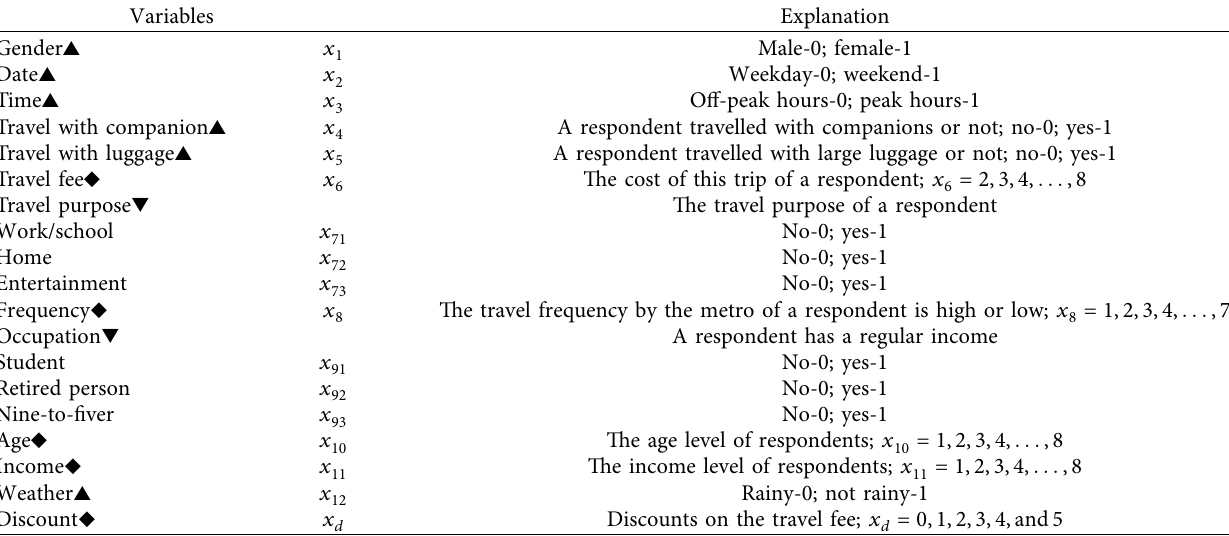
Table 5: Explanation of variables of the regression